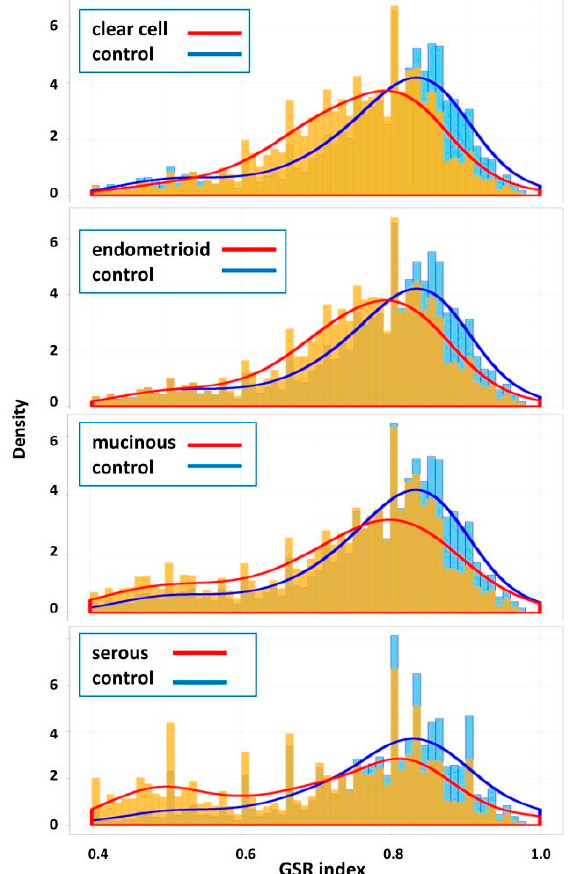
Figure 2. Histograms of the four subtypes. The gene set regularity (GSR) indices for each subtype and normal control group were displayed on the histograms by density. The GSR indices for the two groups showed two distinguishable distributions on the histograms; the distribution consisted of the GSR indices for the EOC subtypes (orange) located on the left side had smaller levels, indicating the biological functions were generally more deregulated in the EOC subtypes than the normal control group (blue).